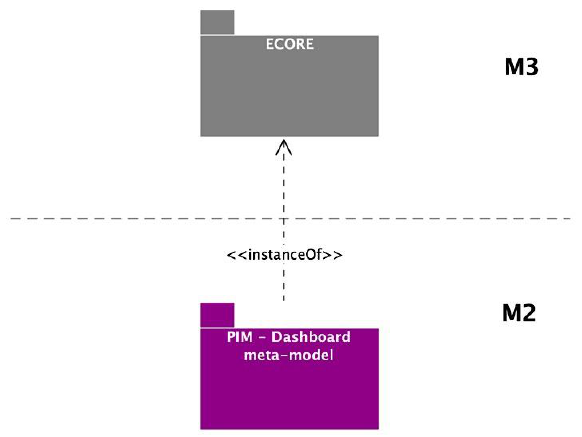
Figure 1. Location of the dashboard meta-model following the OMG architecture.